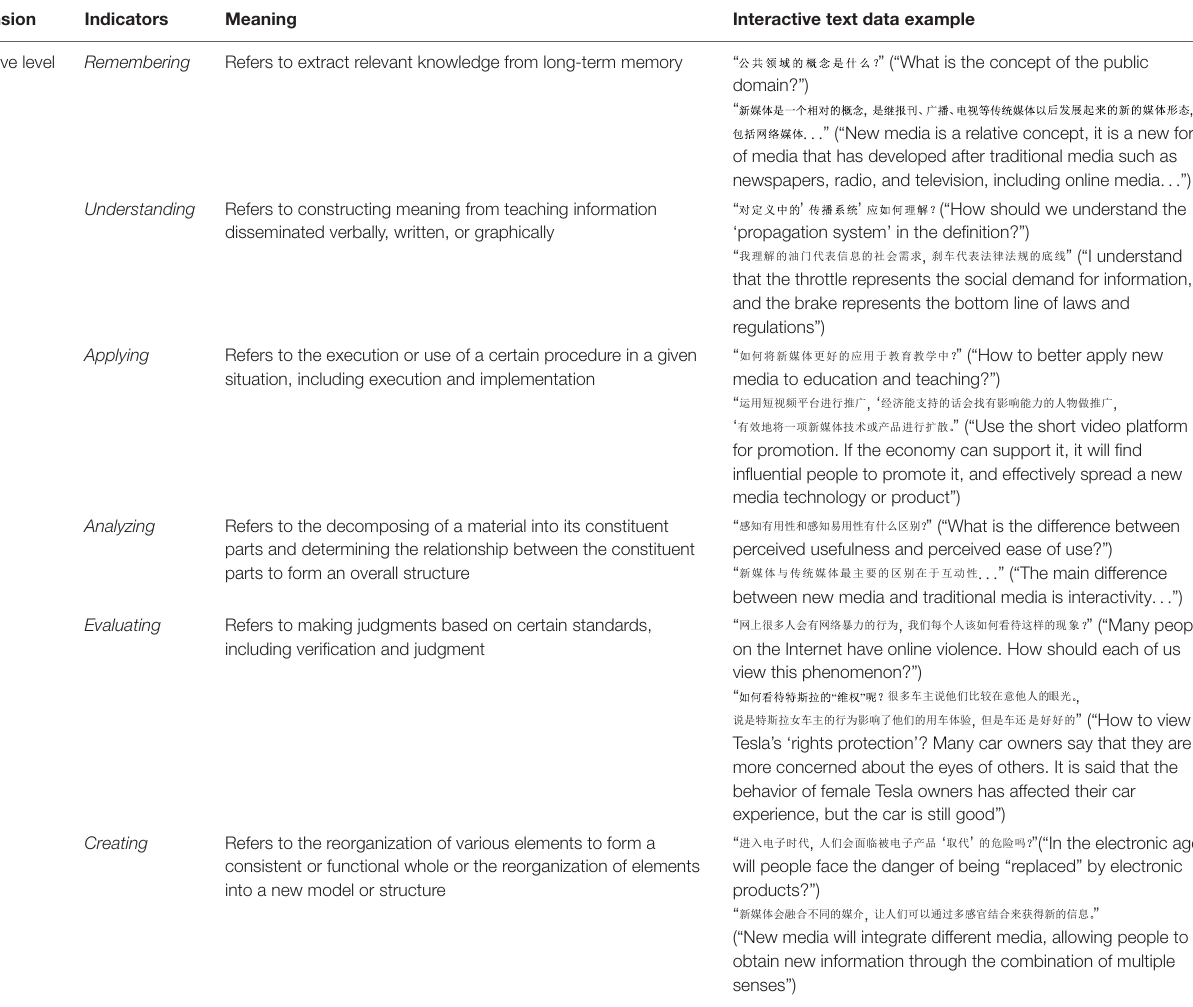
TABLE 2 | Evaluation framework of cognitive level and the data examples.